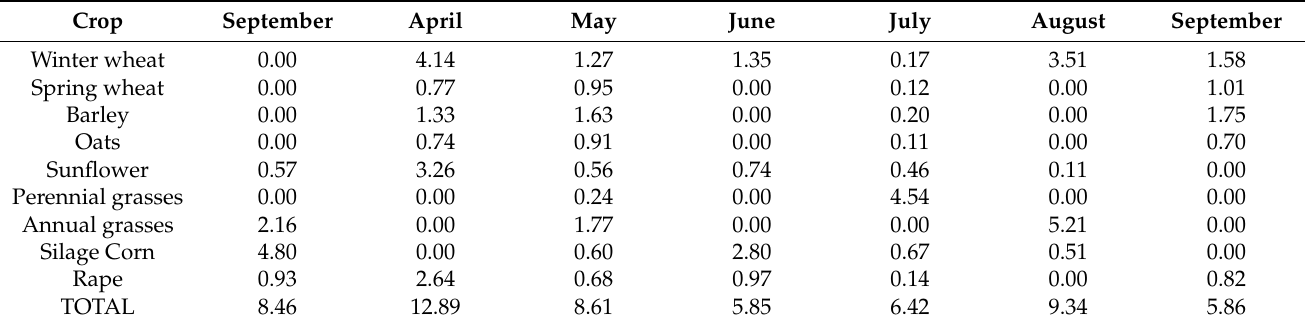
Table 8. Costs of biodiesel for the entire sown area of the enterprise, EUR thousand.